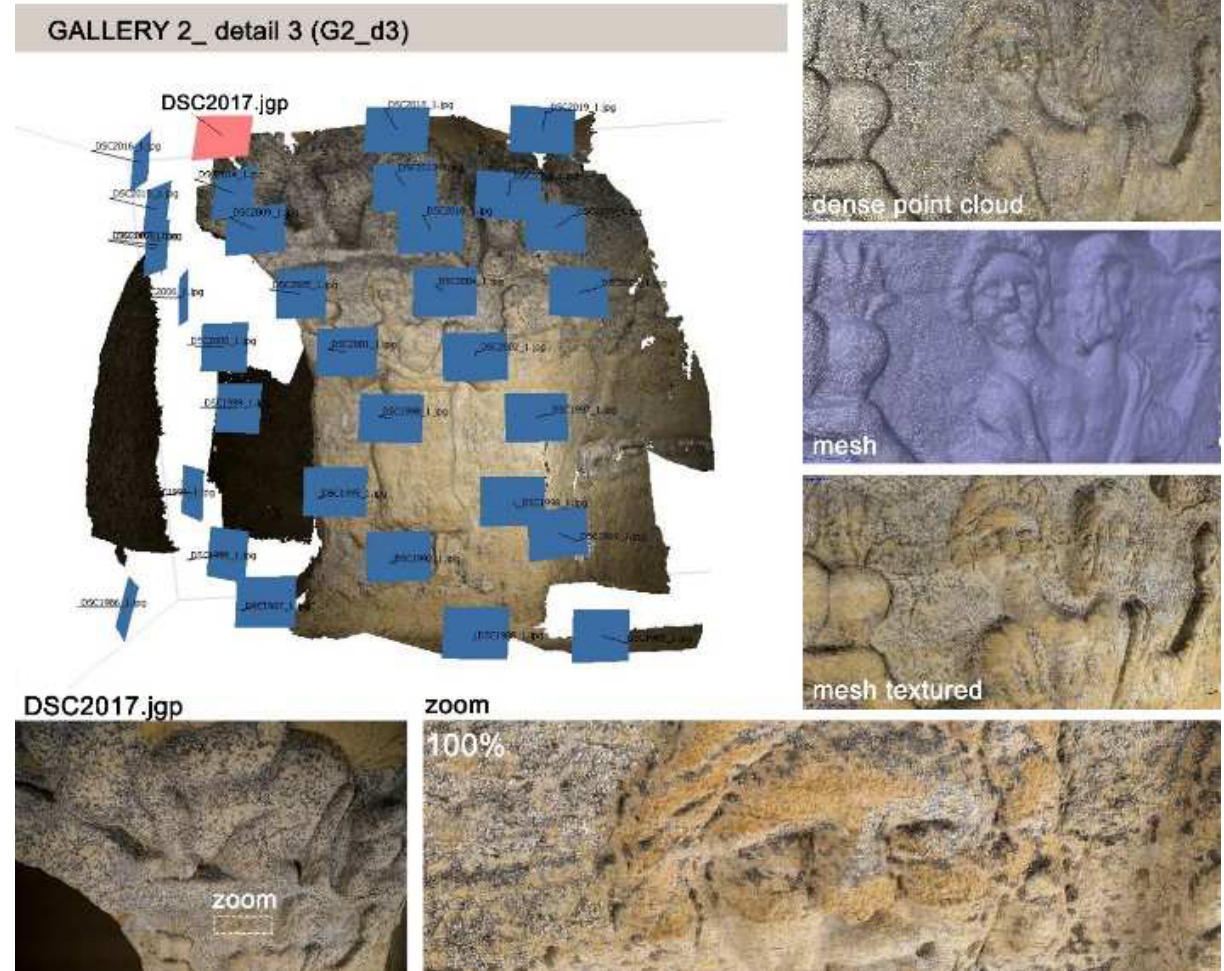
Figure 7: Photogrammetric survey of the detail 3 of second gallery (G2_d3). The first step of data integration was aimed to set the same reference system for all. With the local coordinates obtained manually positioning the GCPs in the TLS point cloud and their corresponding geodetic coordinate captured from GNSS-RTK, TLS point cloud was georeferenced. Then, a minimum of five feature points was manually detected on each bas-relief set of